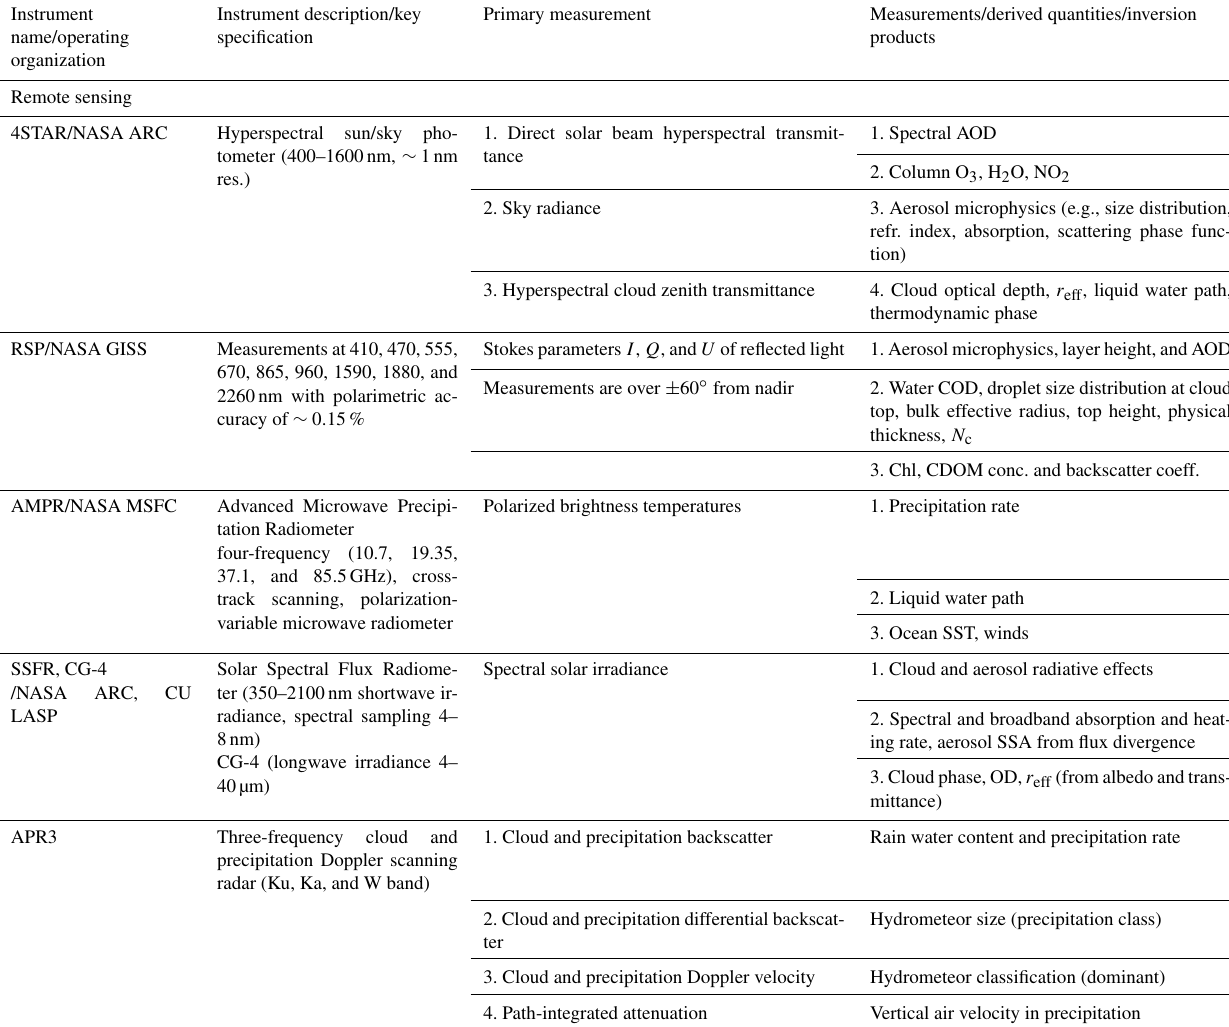
Table B1. P-3 instrumentation in ORACLES (bold entries indicate quantities submitted to the ORACLES archive; see ORACLES Science Team, 2020a–d, in the list of